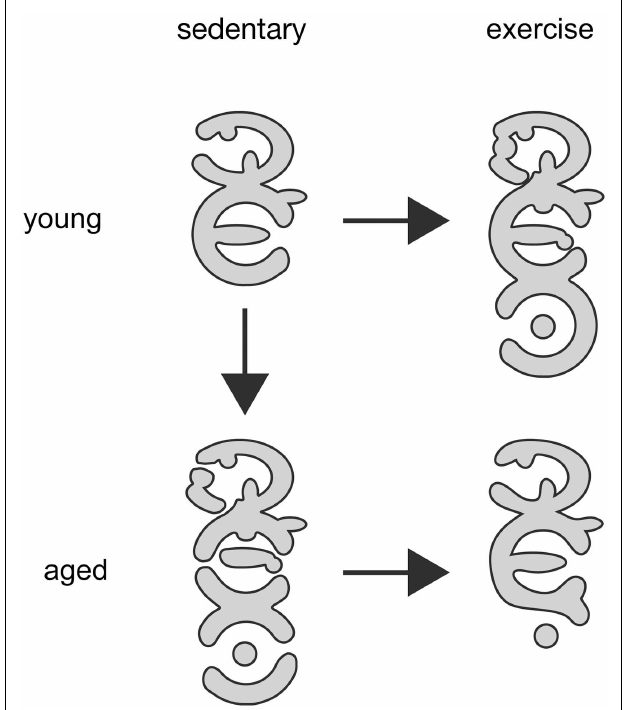
FIGURE 4 | Schematic representation of exercise-induced changes at post-synaptic membrane of NMJ of young adult and aged rodents . Both, exercise as well as the aging process come with augmented size of individual NMJs and increased branching complexity of AChR clusters within the NMJ organization. Aged NMJs are also often characterized by enhanced discontinuity of AChR cluster branches. Of note, exercise of aged animals partially reduces branching complexity, NMJ size, and fragmentation and, thus, leads to a morphology of synapses that resembles young adult sedentary NMJs. Relative density of AChR, indicated by gray scales, is always highest at the branch borders and does not significantly change under all conditions. Pre-synaptic branching and synaptic vesicle numbers (not shown) are largely modified in congruency with post-synaptic changes. However, upon aging partial loss of pre-to-post matching does frequently